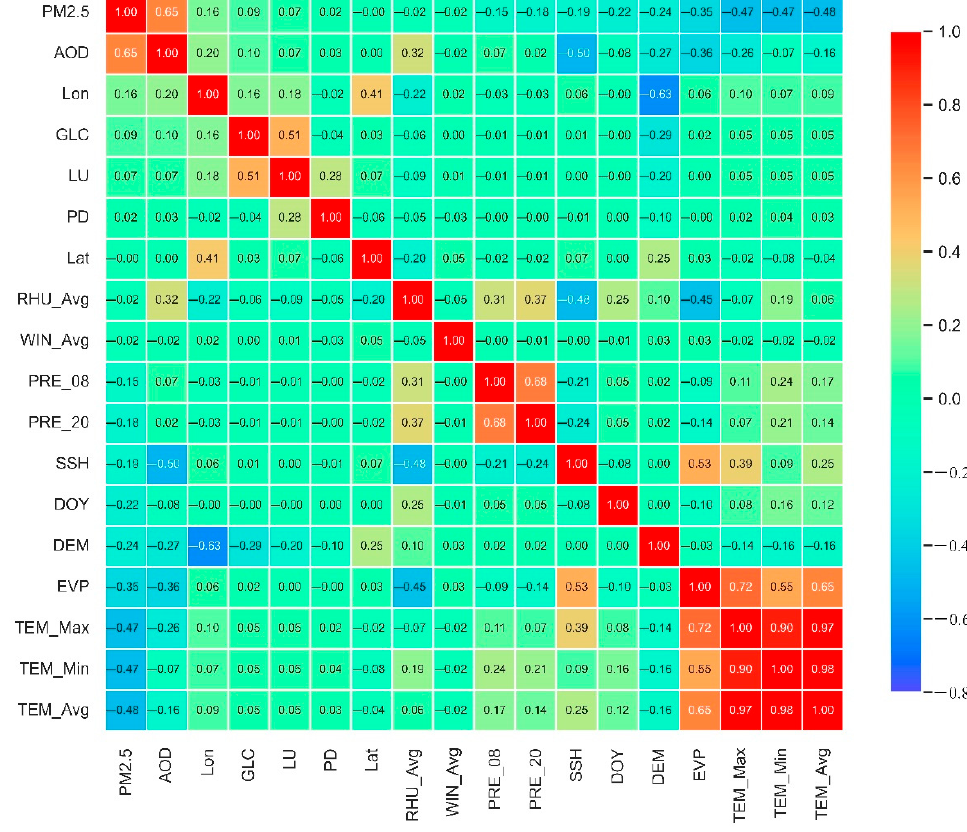
2.5 Observation and each variable in